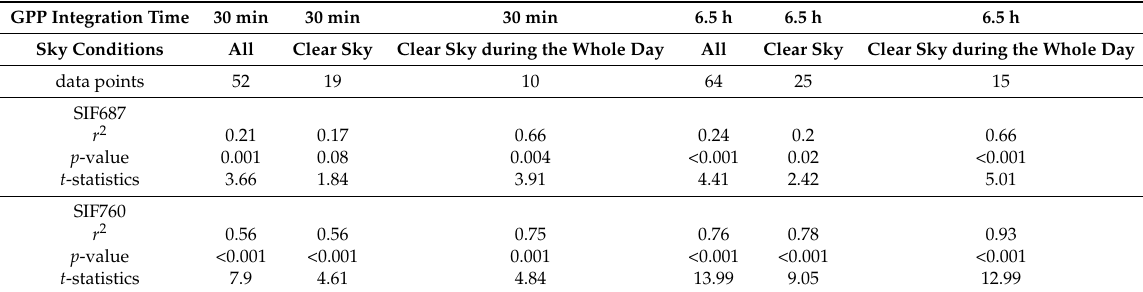
Table 5. Statistics of the linear regression between SIF averaged over 30 min between 12:00 and 12:30 UTC and GPP as a function of experimental conditions. GPP integration time: 30 min, GPP is averaged over 30 min between 12:00 and 12:30 UTC; 6.5 h, GPP is averaged between 8:00 and 15:30 UTC.Sky